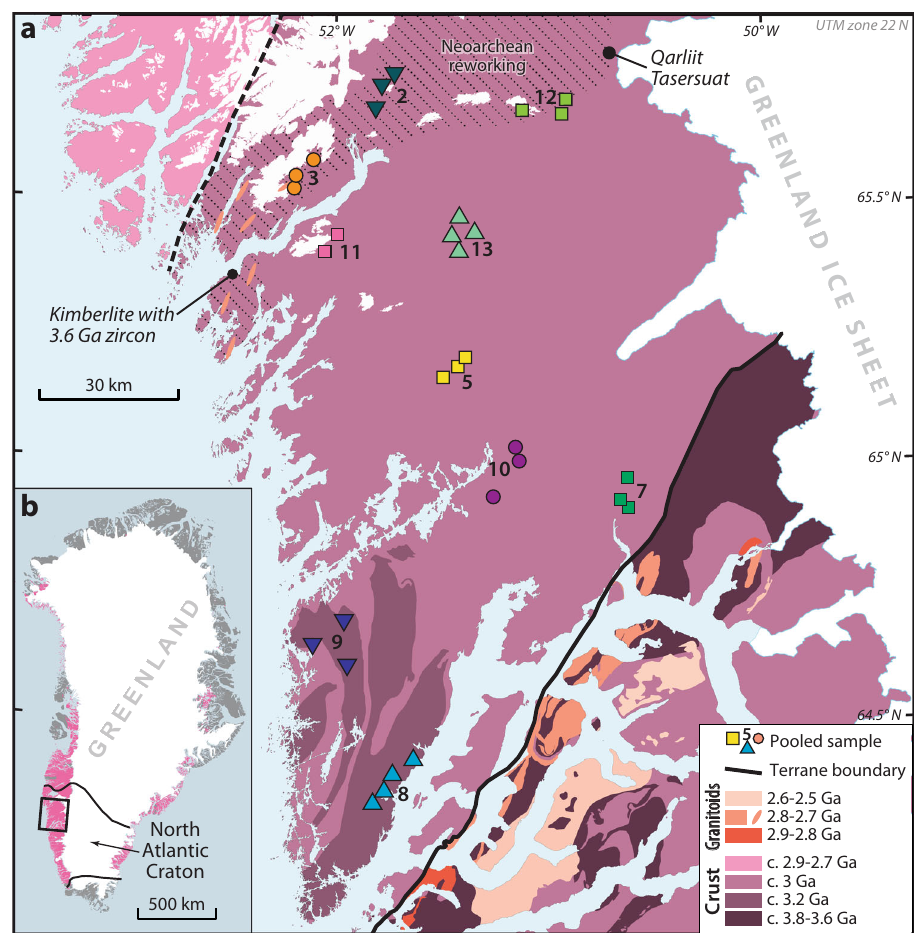
Fig. 1 Lithological age map of the northern part of the North Atlantic Craton. a Lithological age map of the northern part of the North Atlantic Craton showing stream sediment detrital zircon sample locations with sample identi fi cation number. Age map based on new fi eld mapping and interpretations discussed in Friend and Nutman 67 . b Inset shows the location of the study area (black outlined box) with respect to exposures of Archean bedrock (pink hues) in